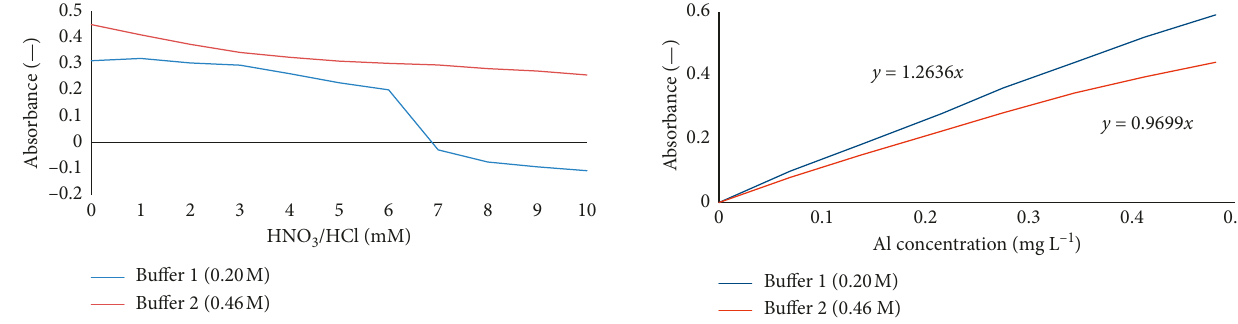
Figure 6: Influence of acetate buffer concentrations on absorbance.